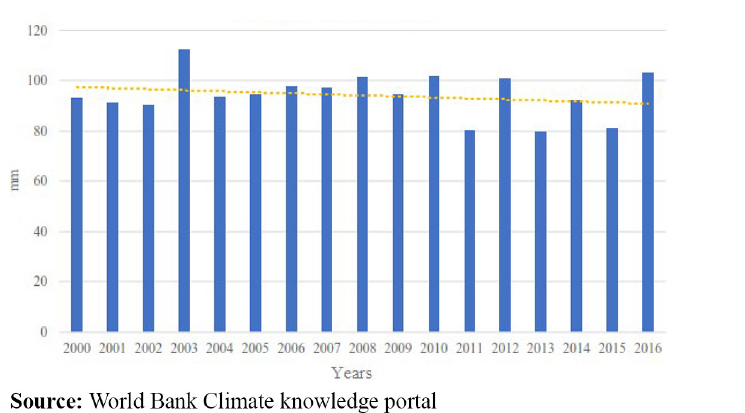
Figure 4. Yearly mean rainfall in Nigeria